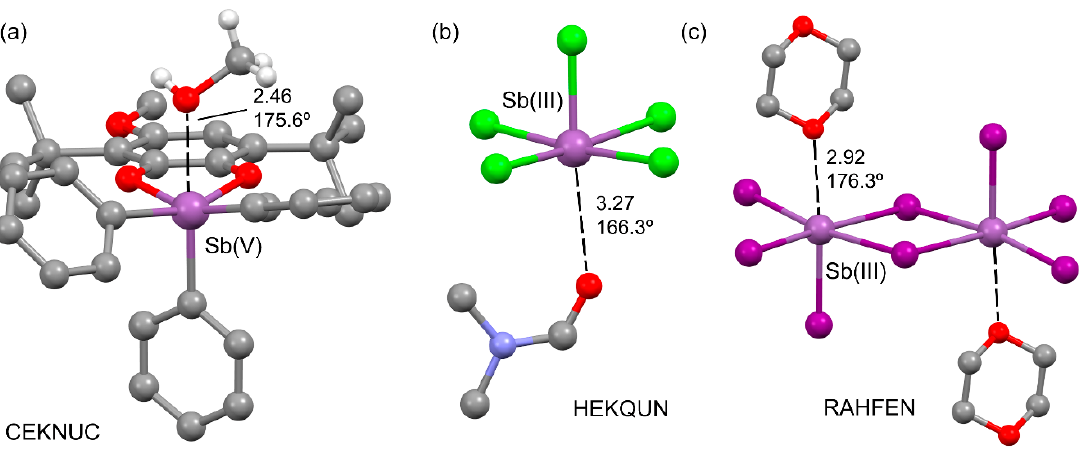
Figure 5. X-ray structures of CEKNUC ( a ), HEKNUC ( b ) and RAHFEN ( c ). H-atoms omitted apart from the methanol molecule in CEKNUC. Distances are given in Å . Color code: Carbon grey, chlo- from the methanol molecule in CEKNUC. Distances are given in Å. Color code: Carbon grey, chlorine rine green, antimony violet, oxygen red, nitrogen blue, iodine purple. green, antimony violet, oxygen red, nitrogen blue, iodine